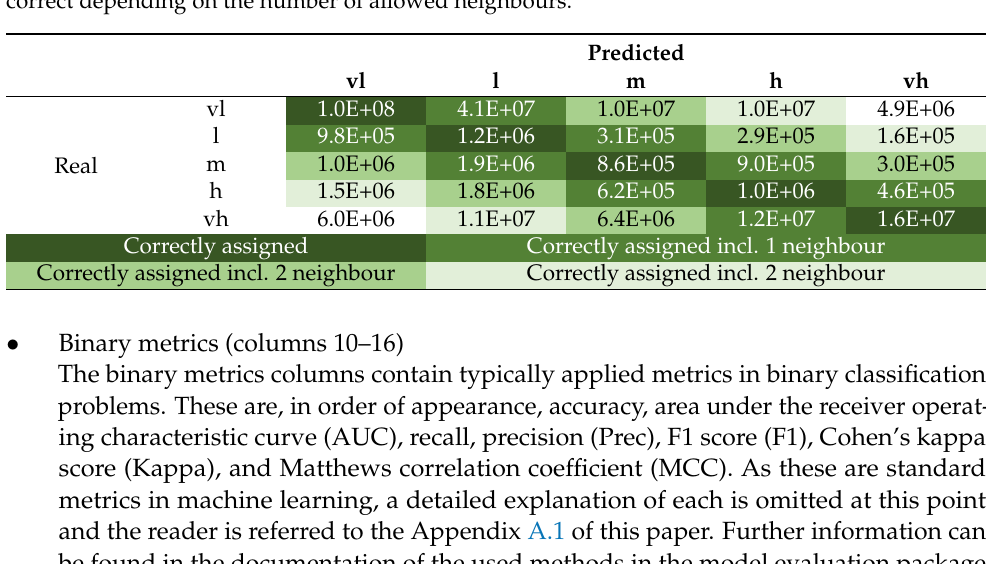
Table 5. Example of confusion matrix, including the information on which values were considered correct depending on the number of allowed